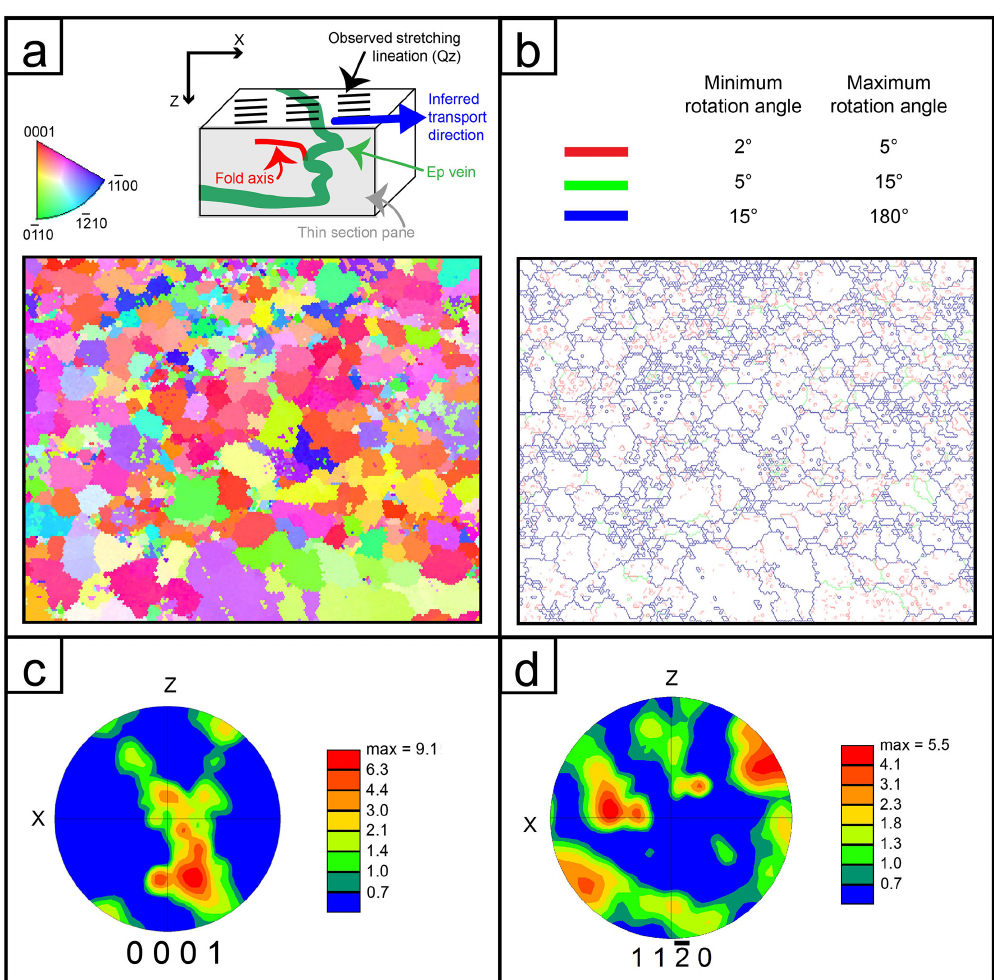
Figure 8. Crystallographic data of quartz in layer 3. ( a , top part). The transpressional deformation produces shearing with some lineation (interpreted as transport direction). The related fold axes are oblique (and possibly curved) to the transport direction and cannot be properly described in 3D. The sketch should illustrate the orientation of the presented axes as shown in panels (c) and (d) . (a) Orientation of quartz grains in layer 3 (pure quartz area); colors correspond to the inverse pole figure shown on top. (b) Misorientation data of the area of panel (a) ; note the dominant high-angle grain boundaries and some minor low-angle boundaries as developed after complete recrystallization, which is indicated by the CPO (shown in c and d ). (c) Pole figure of quartz c axis, indicating a single girdle with relicts of a cross-girdle. (c) The a axes showing the classical distribution of rhomb and basal glide.